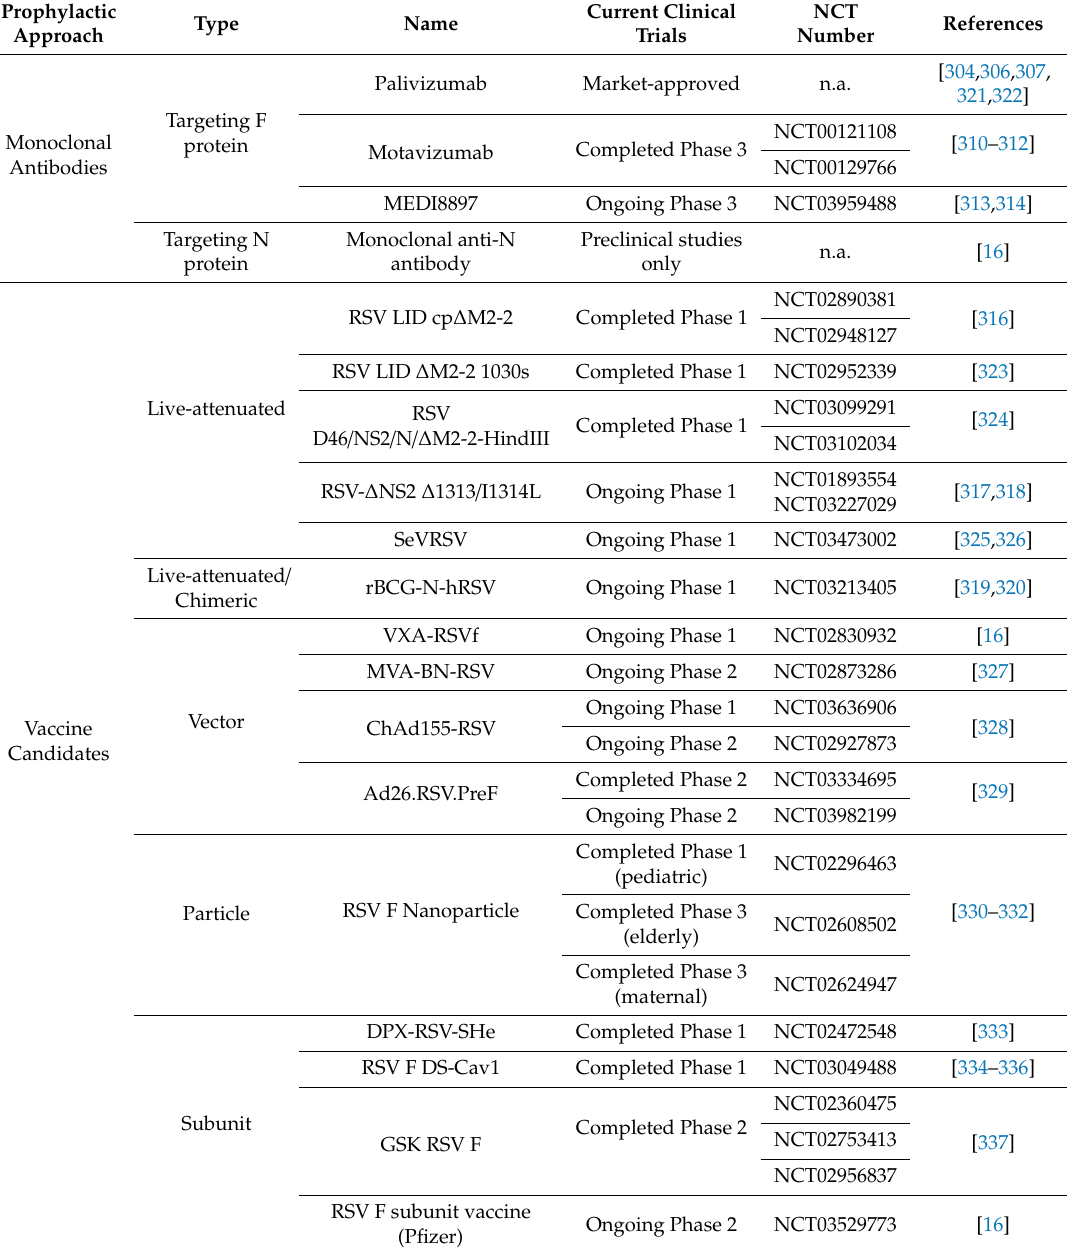
Table 9. Ongoing studies of prophylactic treatments and vaccine candidates against